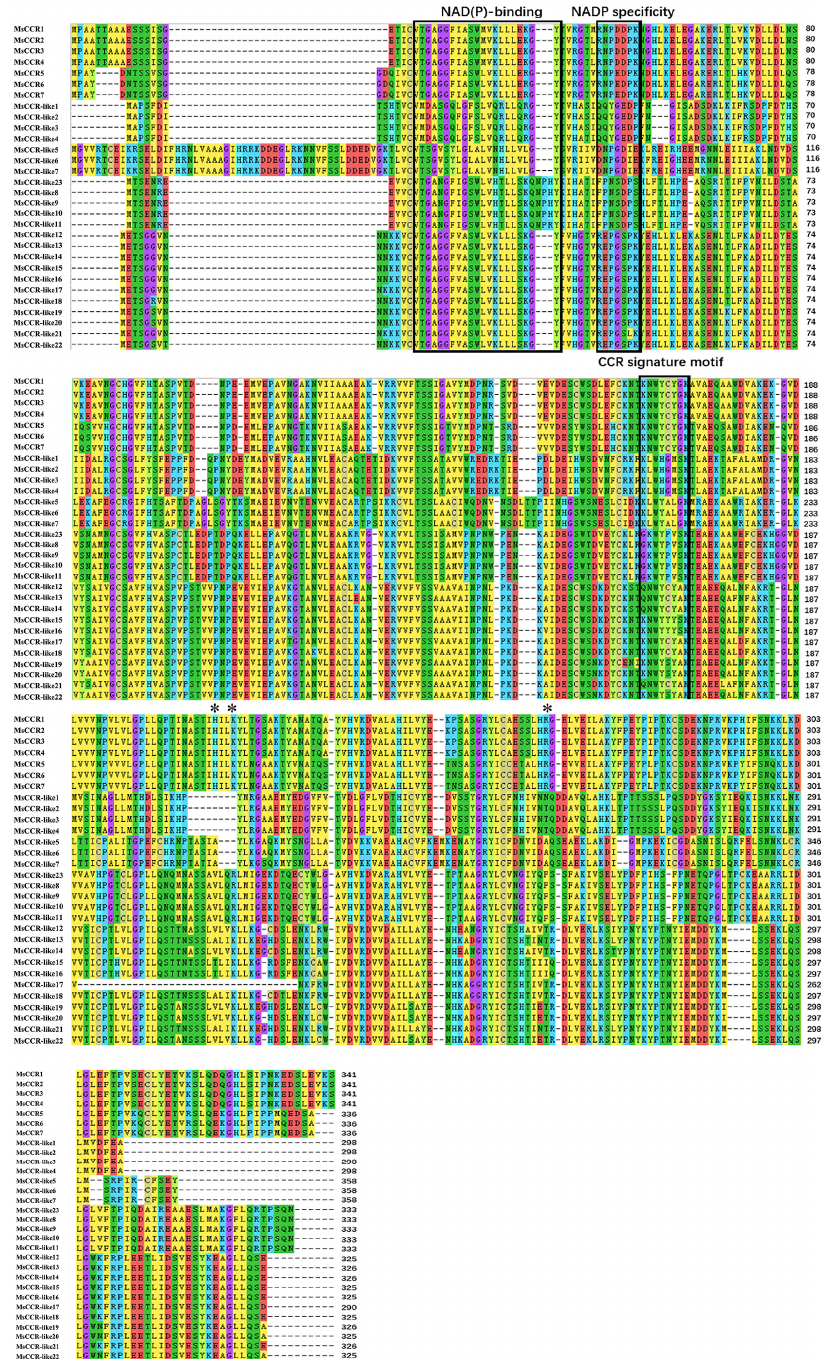
Figure 3. Alignment of MsCCR and MsCCR-like proteins. Conserved motifs are indicated with a black box. “*” indicates the CCR active sites H212, K215, and R263.